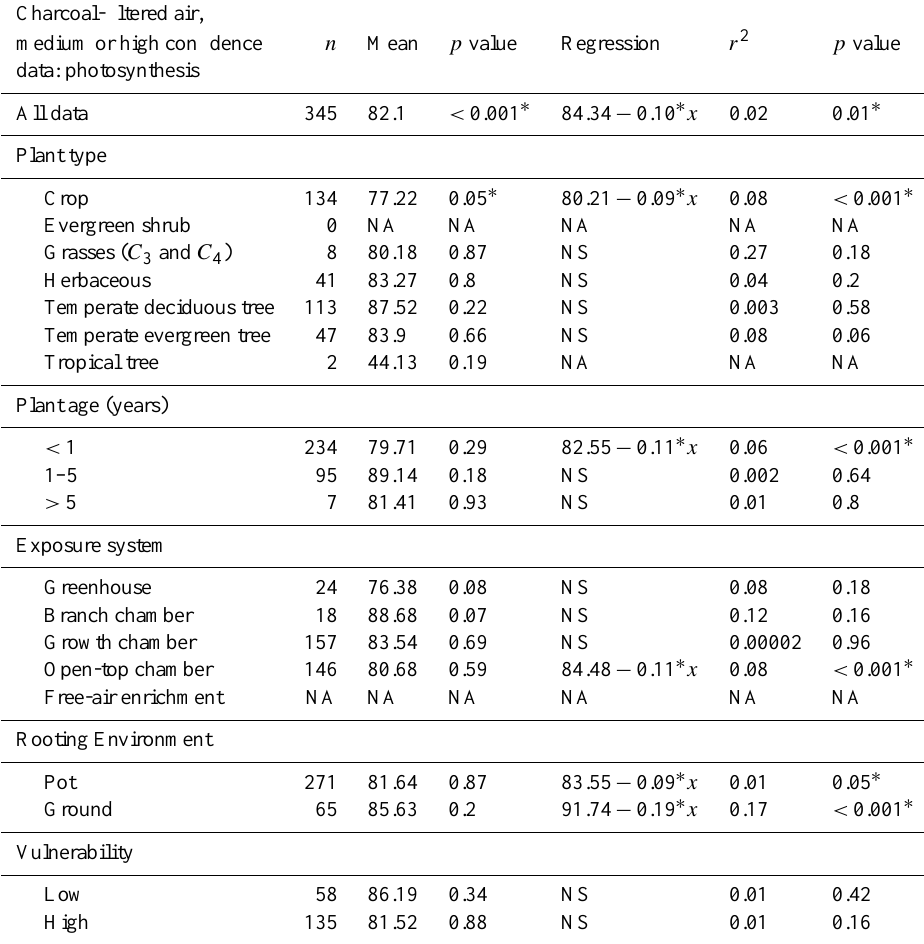
Table 2. The number of data points ( n ), mean, regression, and statistics for photosynthesis when sorted by categories of plant type, plant age, O 3 exposure system, rooting environment, and vulnerability for all data that is compared to control plants exposed to charcoal-filtered air with medium or high confidence in cumulative O 3 uptake (CUO) calculations. All means are reported as the percent of control treatment. The p value for the overall data set (All data) designates whether the overall mean is significantly different from 100 (i.e., 0% change). The p value for the mean within each category designates whether the mean of the category is statistically different from the mean of the overall data set (All data). All regressions are based on the correlation of photosynthesis to CUO for data within the category and are not included if the relationship is not significant (NS). The r 2 is calculated for each regression, and p values designate whether the relationship between photosynthesis and CUO for data within the category is statistically significant. P values are considered significant at p =0.05, and significant values are indicated with ∗